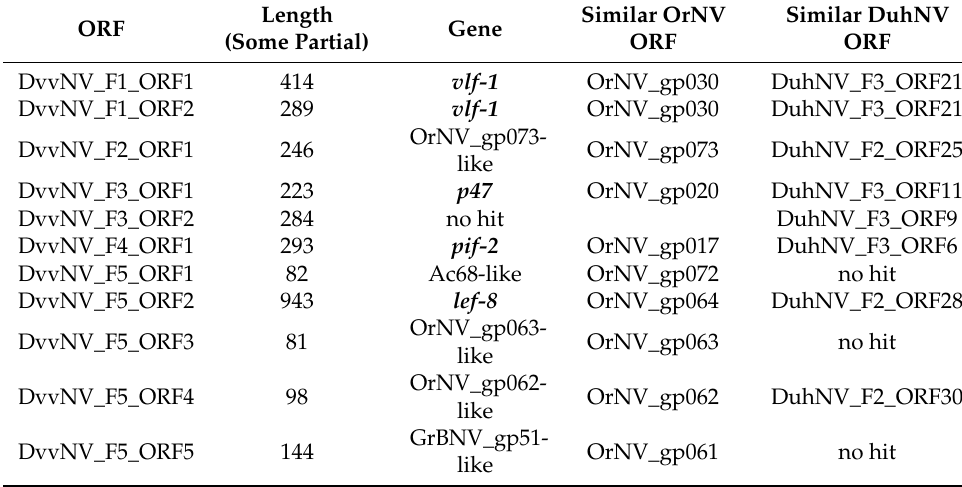
Table 5. Sequence analysis of Diabrotica virgifera virgifera nudivirus (DvvNV). Baculovirus core genes are shown in bold. Genes common to nudiviruses are shown in